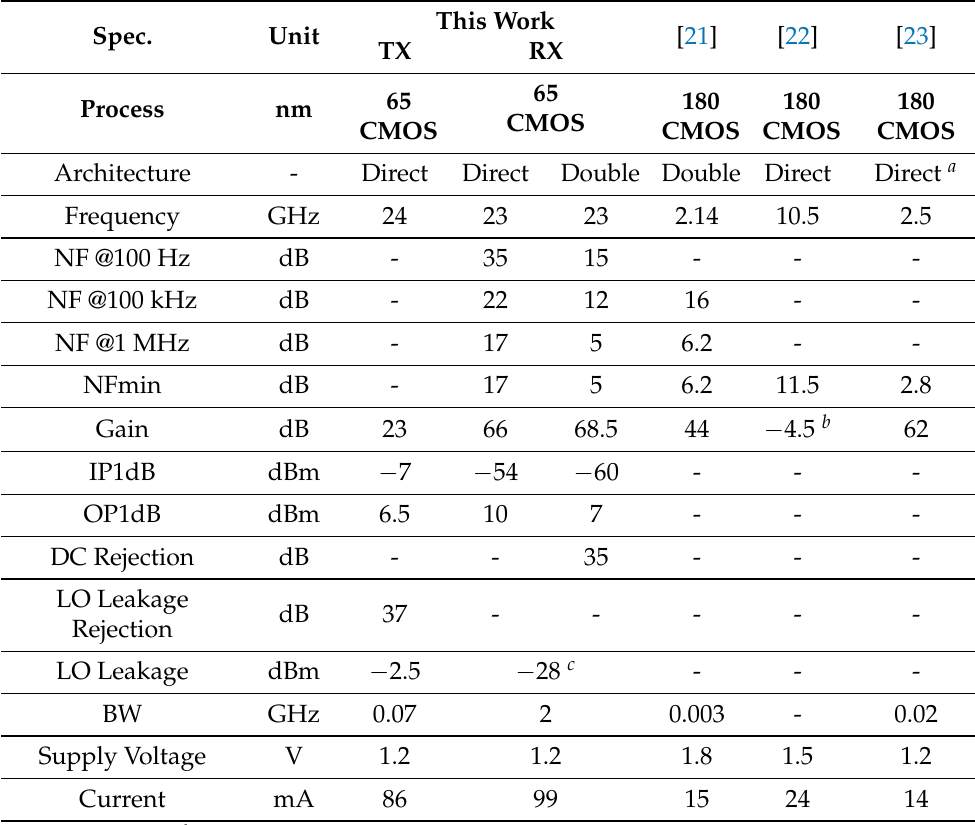
Table 5. Summary and comparison of radar transceiver measurement results.